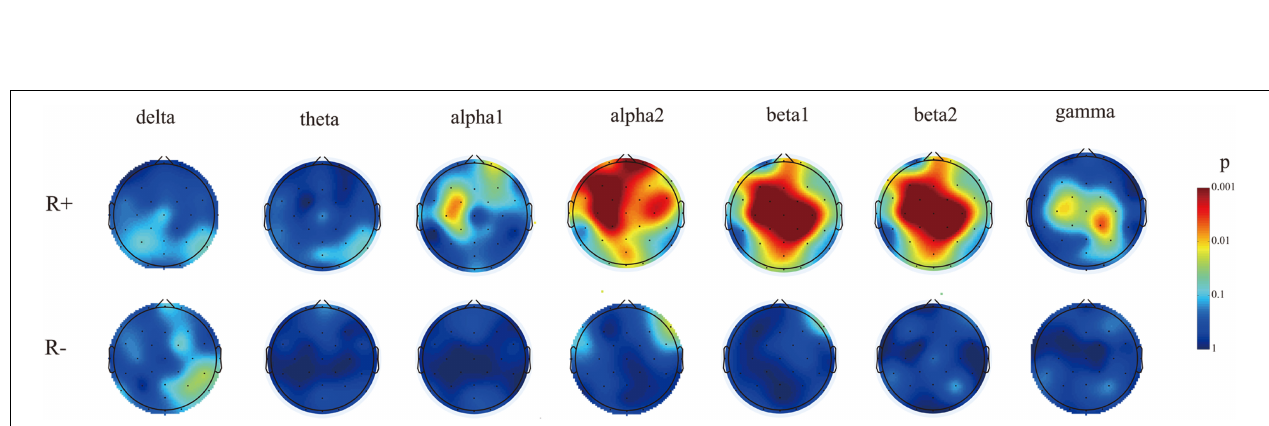
FIGURE 3 | The electrodes with a significant increase in spectral energy after stimulation compared to pre-stimulation in two groups of patients. The electrodes with increased energy in the R + group were mainly concentrated in the alpha2 and beta1 bands, while the R − group only had increased energy in the alpha2 and beta1 bands of F8